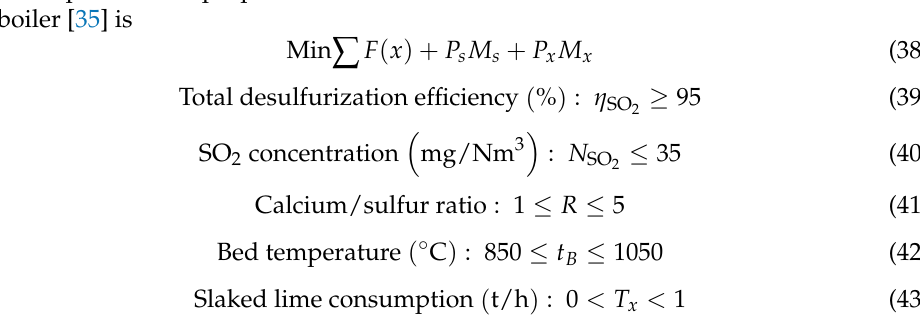
Figure 8. The relationship between slaked lime price and total cost. According to the industrial market, the purity of limestone in the furnace is 90%, and the price is 300 CNY/t; the purity of slaked lime in the desulfurization tower is 95%, and its price is 400 CNY/t. Considering that there are not many variables involved in this arti- cle, and regarding strong nonlinear optimization, sequence quadratic program (SQP) SQP algorithm has better advantages than other optimization algorithms in solving nonlinear optimization problems, and is mainly used to optimize the hybrid optimization model under the MATLAB platform. We analyzed its best operating conditions under various constraints. Under certain conditions, when the influence of boiler thermal efficiency on the desulfurization efficiency of the desulfurization system was not taken into considera- tion, the entire desulfurization system was optimized for different sulfur content of coal slime to obtain the best calcium/sulfur molar ratio, with the goals before and after optimi- zation the value comparison being shown in Figure 9 below.